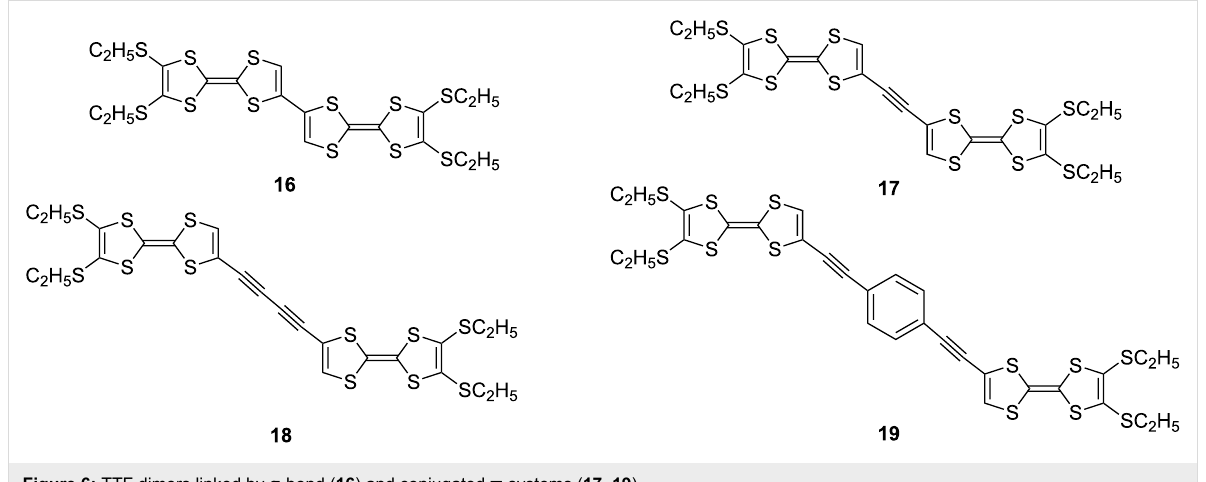
Figure 6: TTF dimers linked by σ -bond ( 16 ) and conjugated π -systems ( 17–19 ).